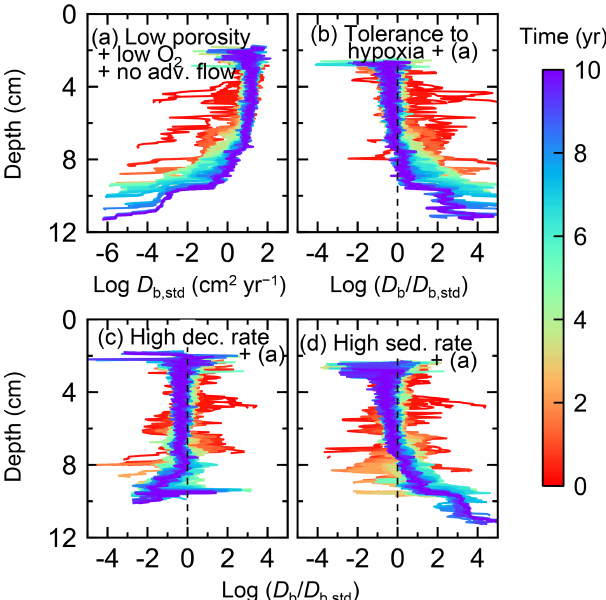
Figure 15. Time evolution of the biodiffusion coefficient ( D b ) ob- tained from 10-year simulations with eLABS. See Sect. 3.3 and caption of Fig. 12 for the details of simulations (a–d) . Note that the D b values are presented only for simulation (a) (denoted as D b , std ); for other simulations (b–d) , the ratios of D b values to those in panel (a) ( D b /D b , std ) are shown to facilitate comparison and dashed vertical lines are references to denote D b = D b , std . Plotted start of the simulations with intervals of 25 model